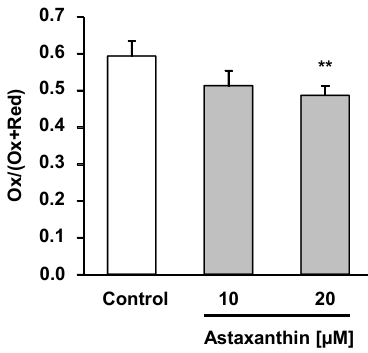
Figure 5. Impact of astaxanthin on the ability of human HepG2 cells to prevent cumene hydroperoxide/hemin stimulated lipid peroxidation. HepG2 cells were seeded at a density of 0.1 × 10 6 cells/well into a 96-well plate and incubated for 24 h. Cells were treated with two concentrations of astaxanthin (10 and 20 μ M) for an additional 24 h. Cells were rinsed and loaded with C11-BODIPY for 30 min and then exposed to cumene hydroperoxide (8 mM)/hemin (8 μ M) for 1 h. Control cells were treated with cell culture medium only. Simultaneously, basal levels of lipid peroxidation were assessed for each treatment concentration (data not shown) and control. Lipid peroxidation was determined by examining the ratio of green (oxidized) and the sum of green and red (oxidized + non-oxidized) emissions using a fluorometric plate reader. Data are means + SD of at least two independent experiments performed in duplicate. ** p < 0.01, one-way ANOVA Games–Howell.